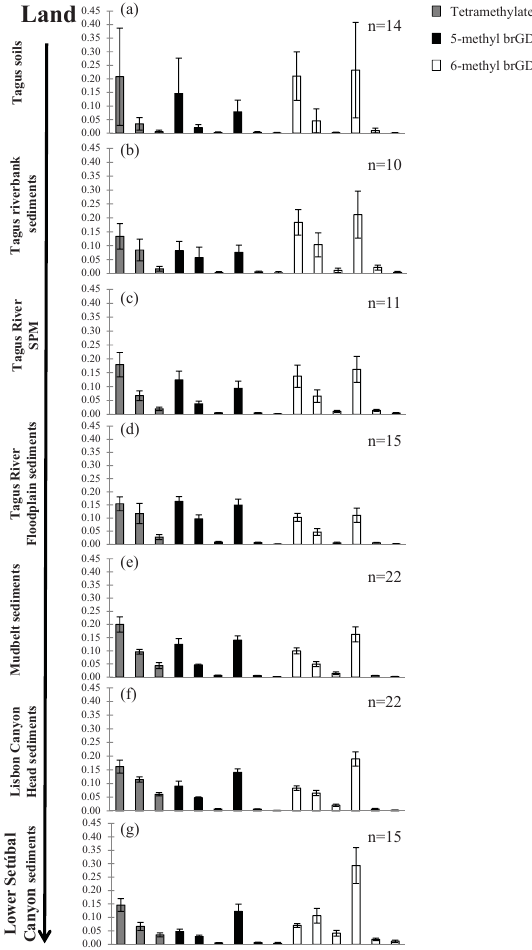
Figure 5. Average distribution of brGDGTs for each sample set along the transect of samples that runs from the land to the ocean off the coast of Lisbon. Evident from this figure is that the distribu- tion of brGDGTs within this sample set varies greatly. Distributions of brGDGTs in marine sediments only reflect the distribution of the brGDGTs from the Tagus soils to a minor extent. The color of the bars reflects the brGDGT structure as labeled in the legend, and the range indicated with the error bars equals 2xs the standard devia-